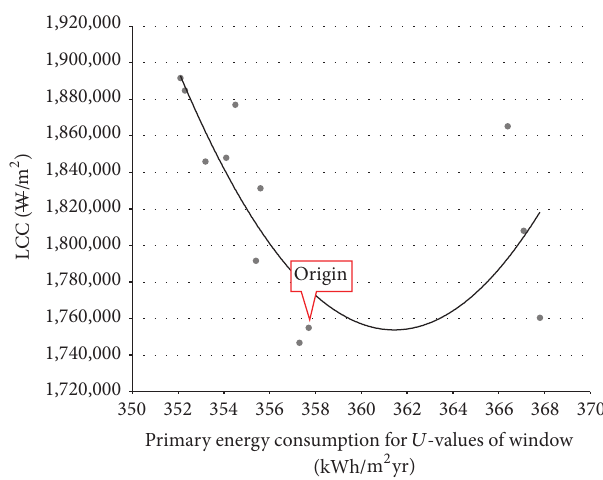
Figure 4: LCC depending on the primary energy consumption according to the window